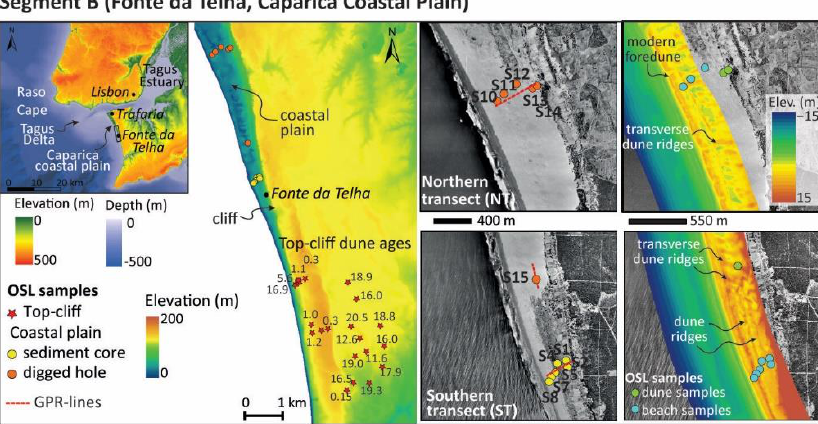
Figure 3. Detail of the location and morphology of Segment B, including the age of the top-cliff dunes based on [15,16] and the new sampling (for dating and geophysical image collection) carried out in the coastal plain.